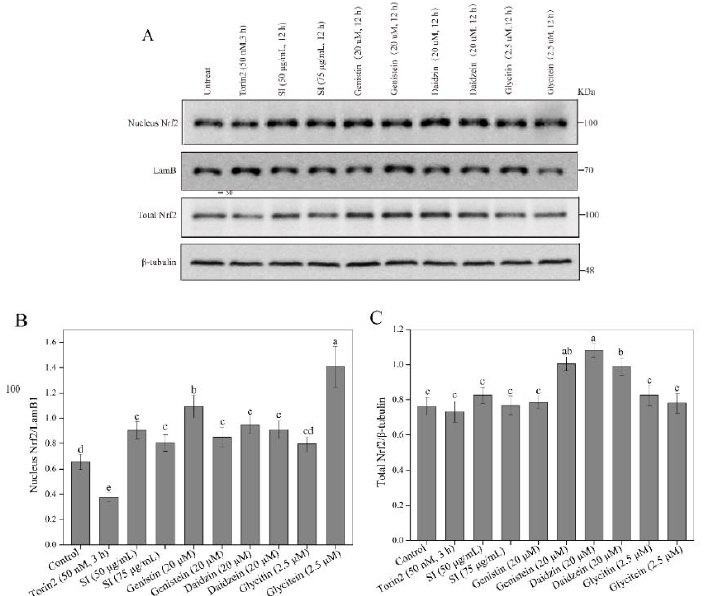
Figure 4. Effects of isoflavones on Nrf2 protein activation. ( A ) Western blot analysis of Nrf2 protein. ( B ) The relative expression level of nuclear Nrf2 protein. ( C ) The relative expression level of total Nrf2 protein. Means with different small letters were significantly different ( p < 0.05).